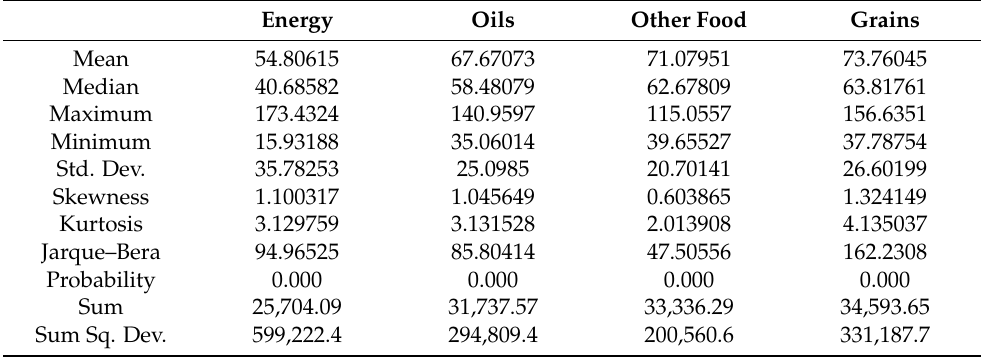
Table 1. Descriptive